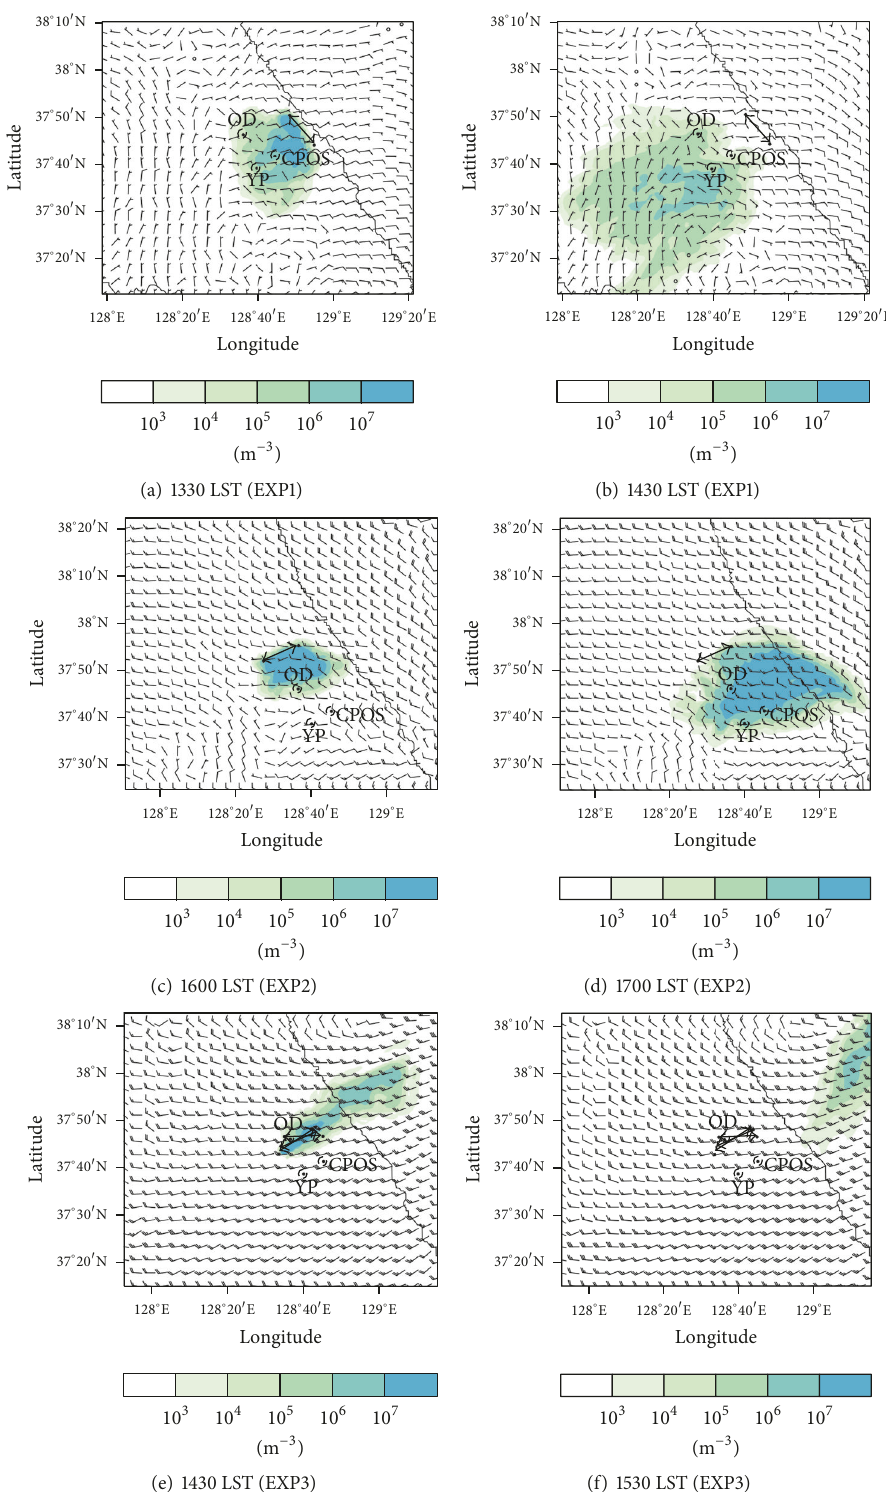
Figure 4: The accumulated AgI number concentration (m −3 ) for the SEED simulations from the surface to 3,000 m (MSL) for EXP1 (a, b), EXP2 (c, d), and EXP3 (e, f). The vector represents the wind field at the seeding